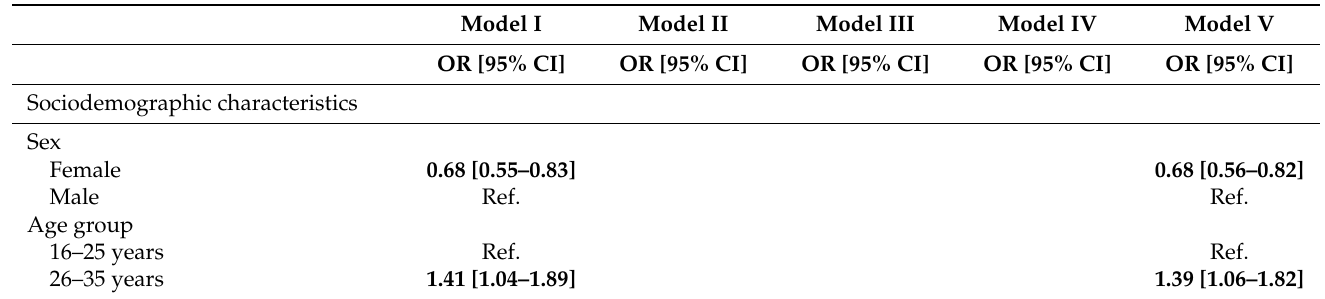
Table 2. Determinants of (very) frequent intentional outdoor tanning based on logistic regression